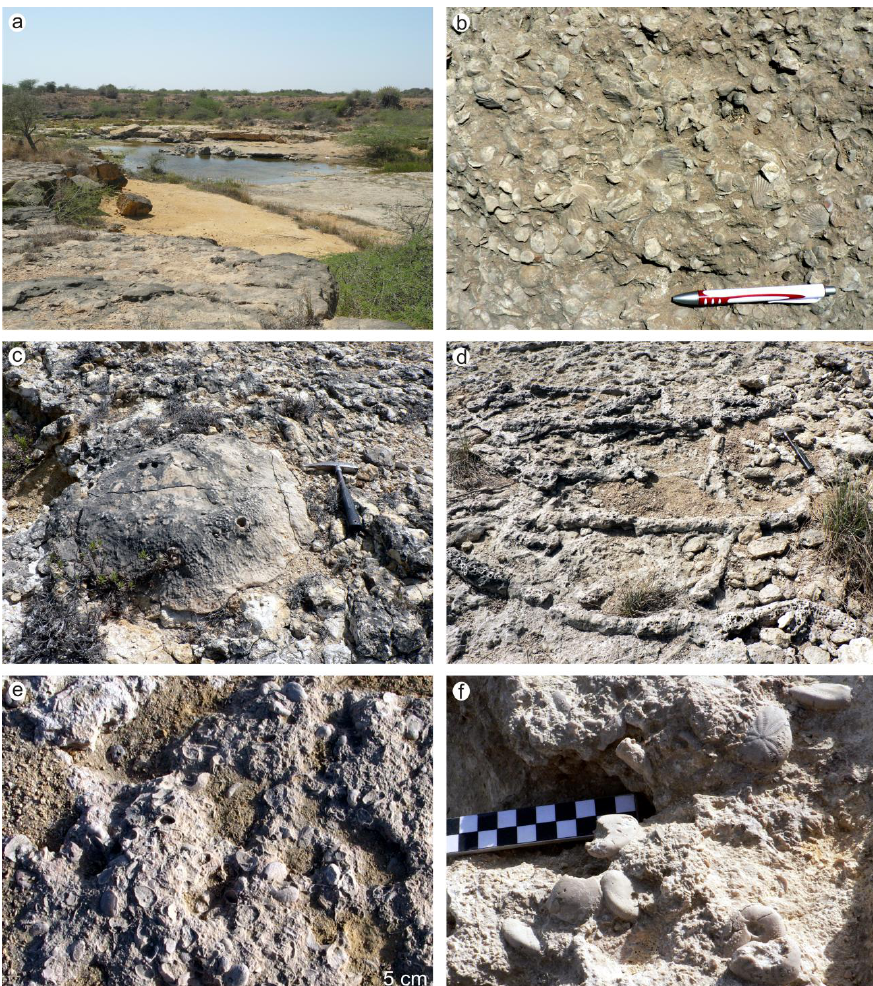
Fig. 3. Field aspects of tempestite facies in the Maniyara Fort Formation. (a) Vast tempestite shell beds exposed in the bed of Bermoti River. 1054 (b) Large lepidocyclinids are the dominant constituent of tempestite deposits in the lower part of the Coral Limestone Member. (c) Massive coral colony encrusting the surface of a tempestite shell bed; Coral Limestone Member. (d) Extensive decapod burrow system at the top of a larger foraminiferal shell bed; Coral Limestone Member. (e) Mass accumulations of irregular echinoids characterise the tempestite deposits of the Bermoti Member. (f) Concentration of Eupatagus coronas in lepidocyclinid rudstone facies; Bermoti Member. One square on the graphic scale is